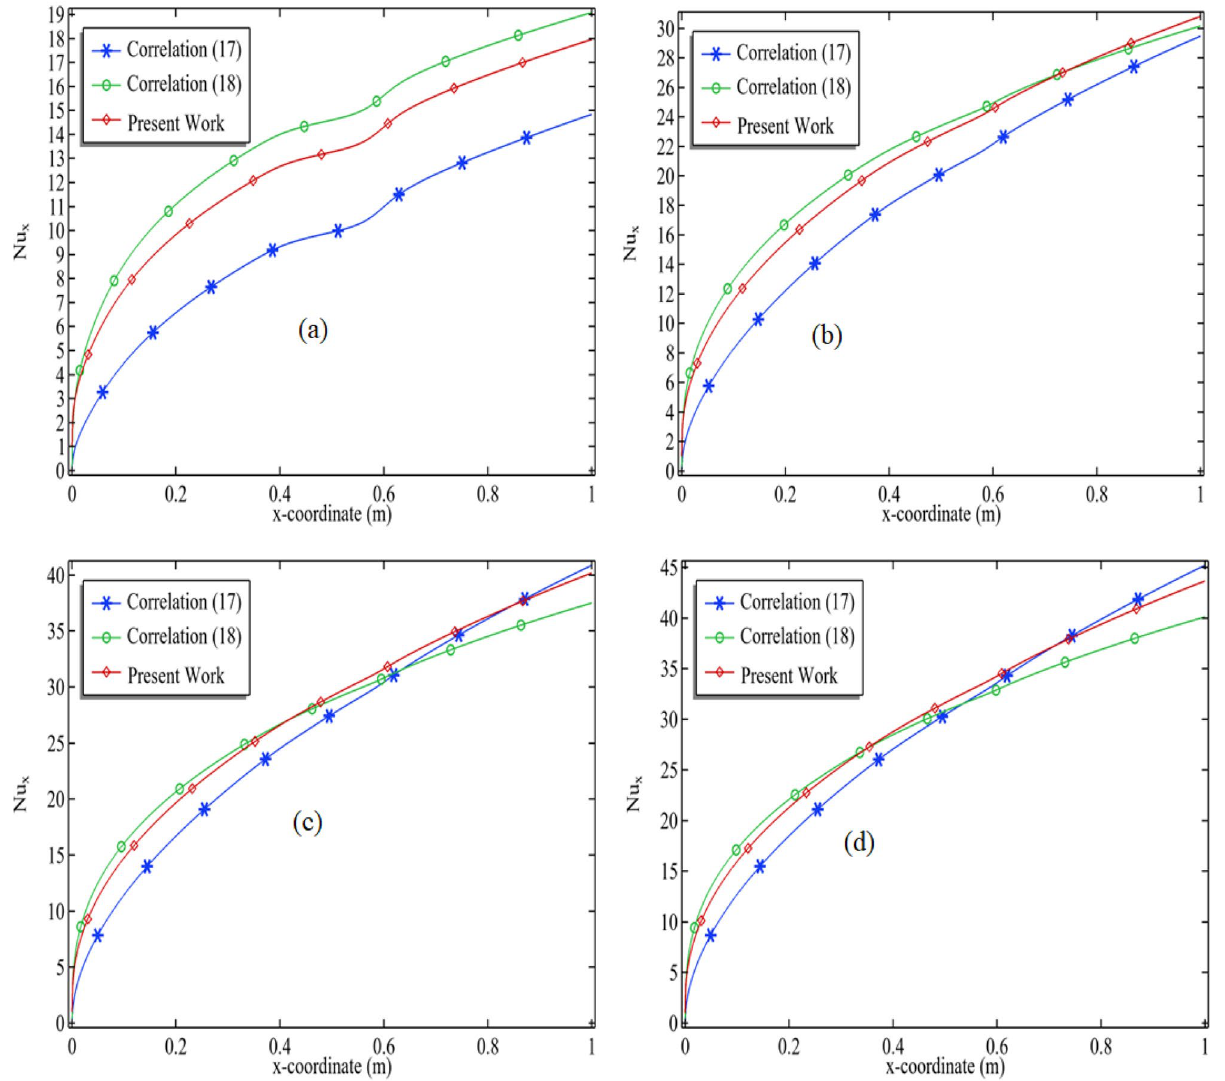
Figure 4. Validation of the code by calculating the local Nusselt number at the position y = H/2 when ( a ) Re = 100 ( b ) Re = 400 ( c ) Re = 800 and ( d ) Re =